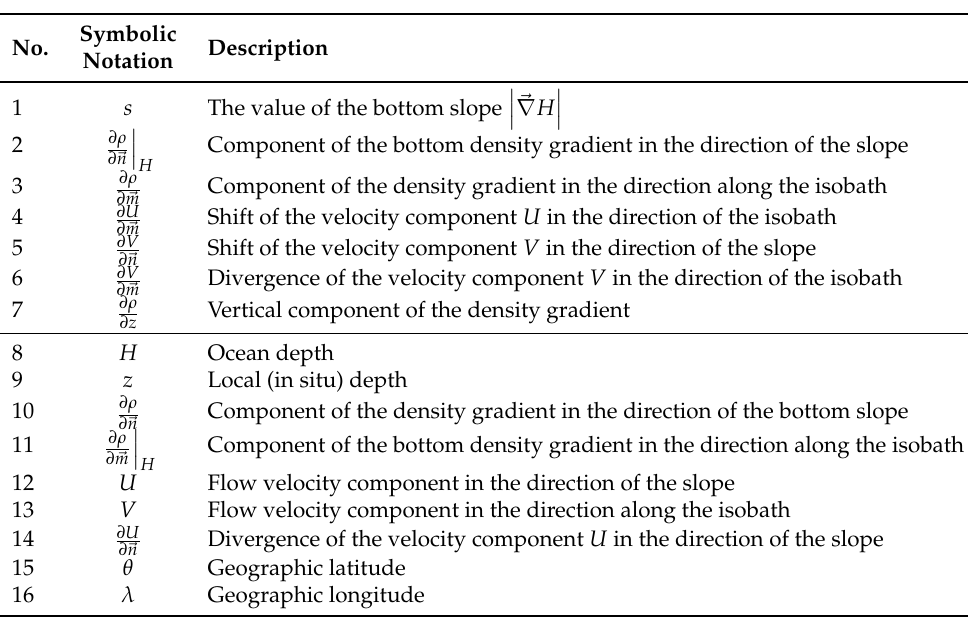
Table 1. Geographic and physical large-scale characteristics, used for analysis of eddy mass transport dependencies. Here (cid:126) n = direction along the isobath. The first seven characteristics are selected after their dependency